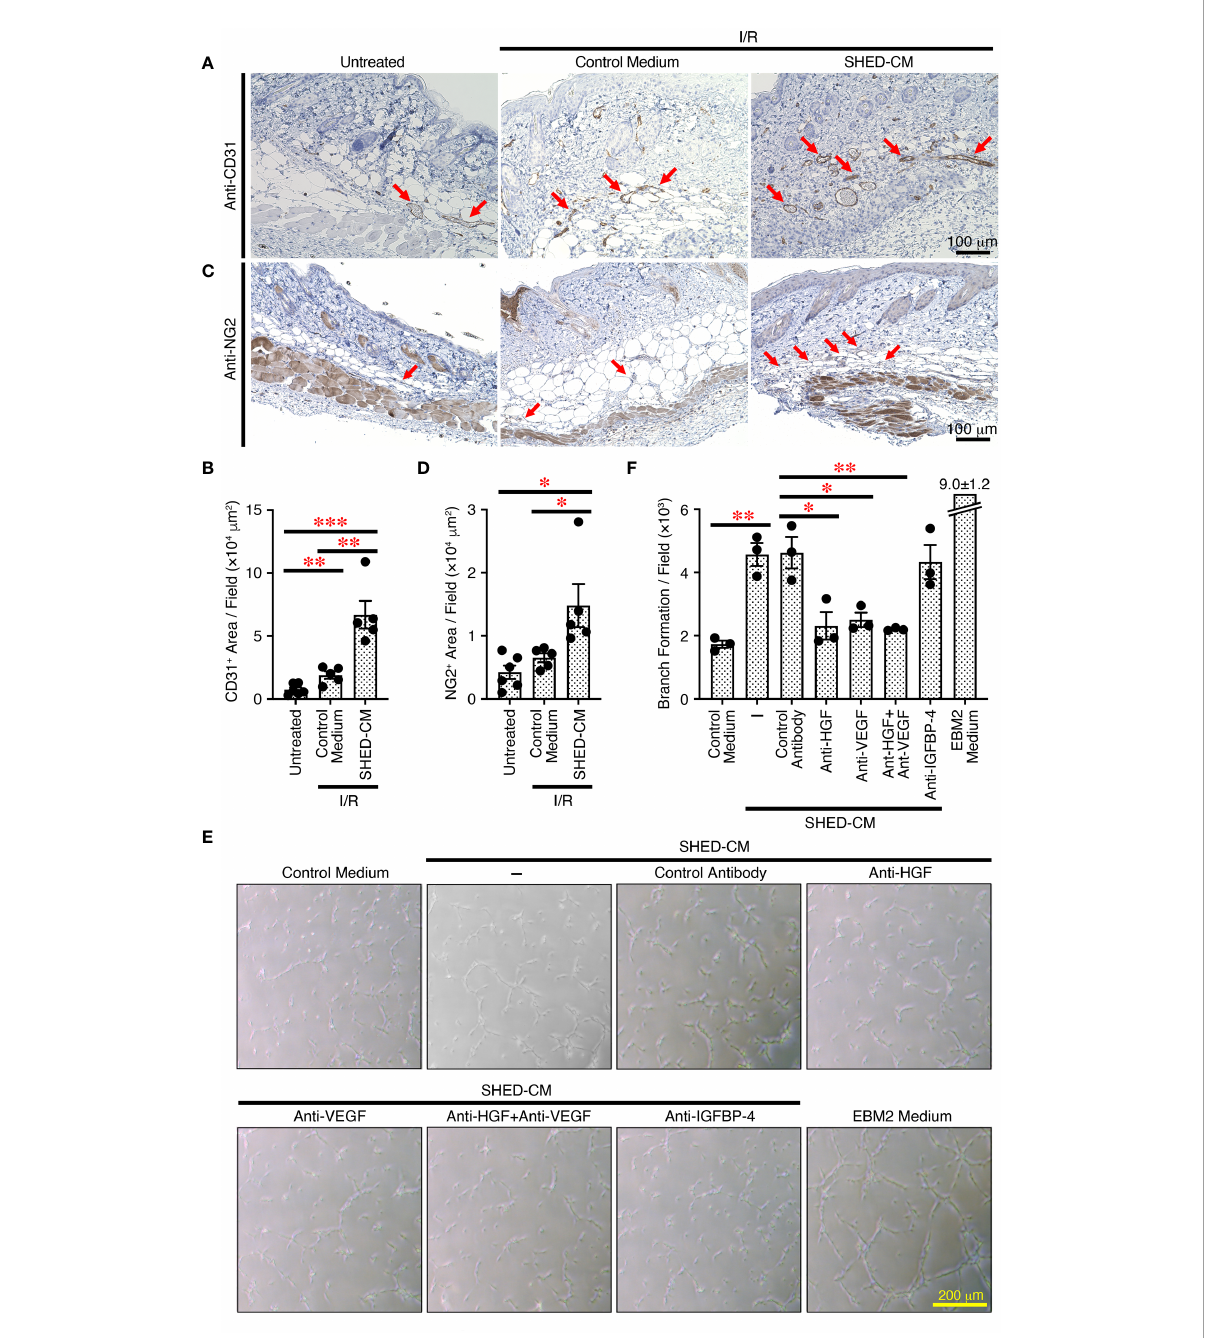
FIGURE 6 SHED-CM promotes angiogenesis through VEGF and HGF. (A, C) Mouse dorsal epidermal tissues of ulcers were removed on day 4 and immunohistochemically analyzed for expression of the endothelial cell marker CD31 and pericyte marker NG2 counterstaining with Mayer ’ s hematoxylin. Representative photographs for CD31 (A) or NG2 (C) are shown. Positive areas for CD31 or NG2 were calculated using FIJI (B, D) . Data are shown as the mean ± SEM (n = 5~6) and are representative of two independent experiments. (E) Angiogenic activities of SHED-CM, control medium, or VEGF- or HGF-depleted SHED-CM with respective antibodies, control antibodies-treated SHED-CM were determined using a tube formation assay with HUVECs. Representative photographs of the tube formation are shown. (F) Total tube area and branch formation rate were quanti fi ed using FIJI. Data are shown as the mean ± SEM in triplicate and are representative of fi ve independent experiments. P values were determined by one-way analysis of variance with the Tukey multiple comparisons test. * P < 0.05, ** P < 0.01, *** P <